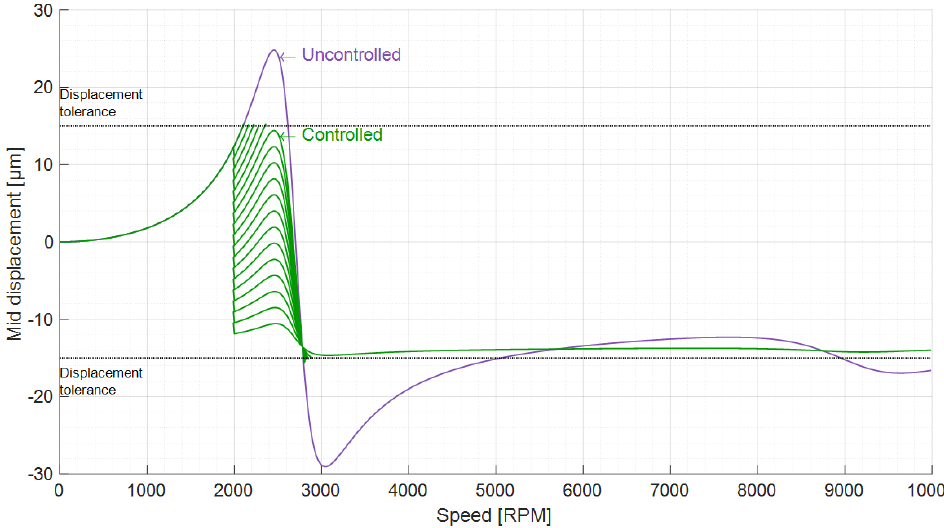
Figure 12. Adaptive algorithm action on the rotor mid-point radial displacement, with a 15 µ m radial displacement tolerance and 2000 RPM as the adjusting